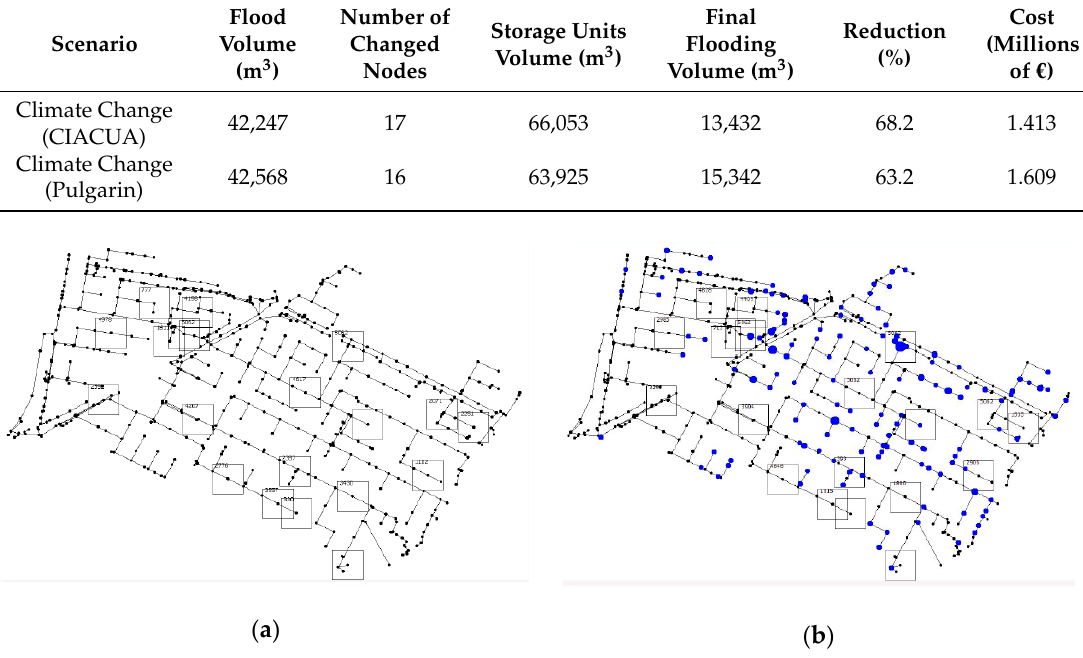
Table 2. Results for the Southern Chic ó Network using OptSU under Climate Change scenarios.